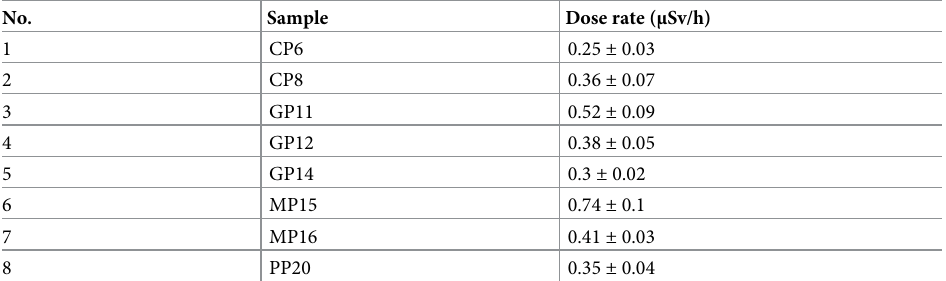
Table 4. Dose-rates from pendants, obtained using the IdentiFinder 2, portable meter.